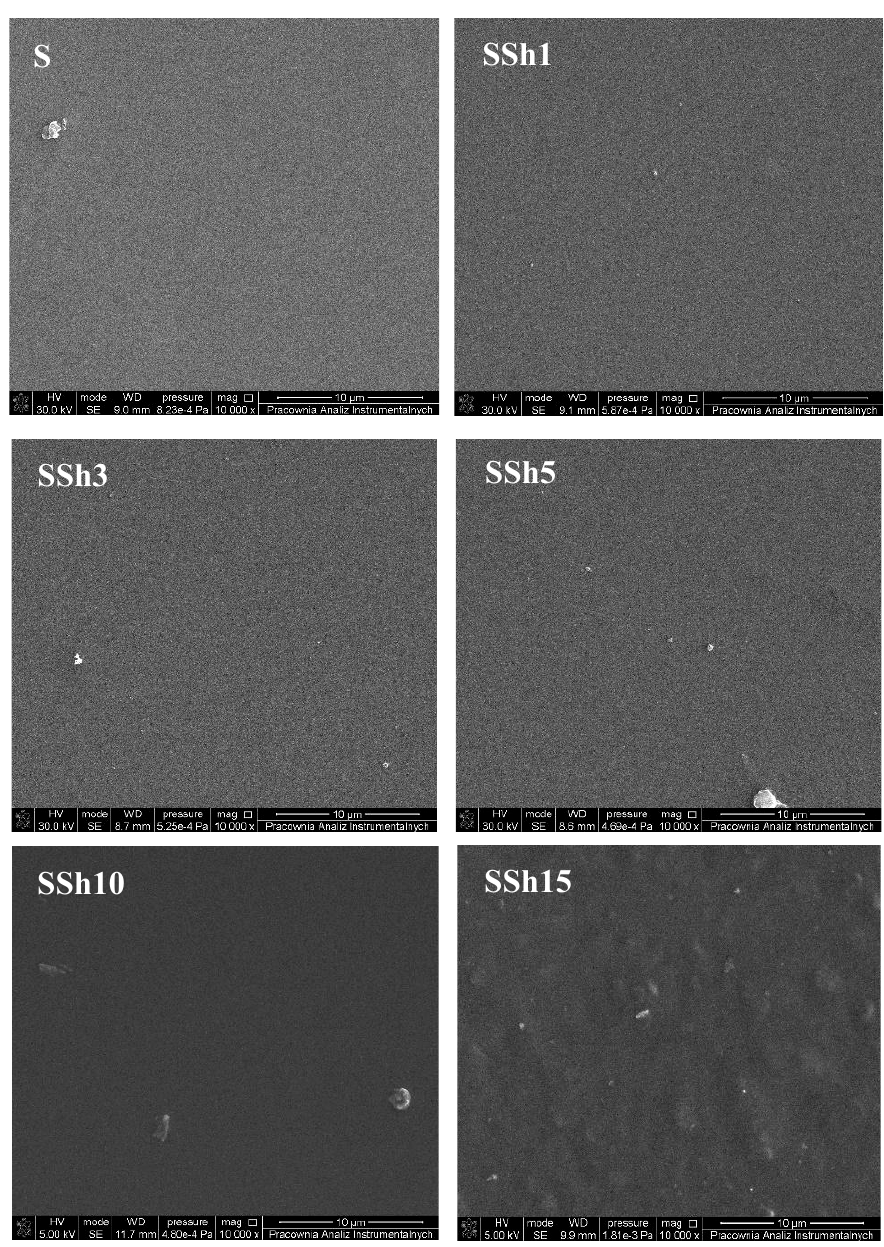
Figure 5. SEM images of elastomer and polymer matrix filled with shungite. Cross-sections of pure polymer matrix and PDMS filled with both carbonaceous fillers are presented in Figures 6 and 7. It can be clearly seen that while the surface of the obtained materials seems to be characterized by universally dispersed additives, the cross-sections reveal different dispersions of graphite and shungite introduced into the system. In the case of a sample with an addition of 1 wt.% of graphite, the filler seems to be uniformly distributed throughout the entire mass of the obtained composite. The increase in the amount of additive (3 and 5 wt.%) allows to obtain films where the graphite is deposited mostly in the upper level of the materials. The addition of 10 and 15 wt.% of graphite leads to the dispersion of filler throughout the entire mass of Sylgard.